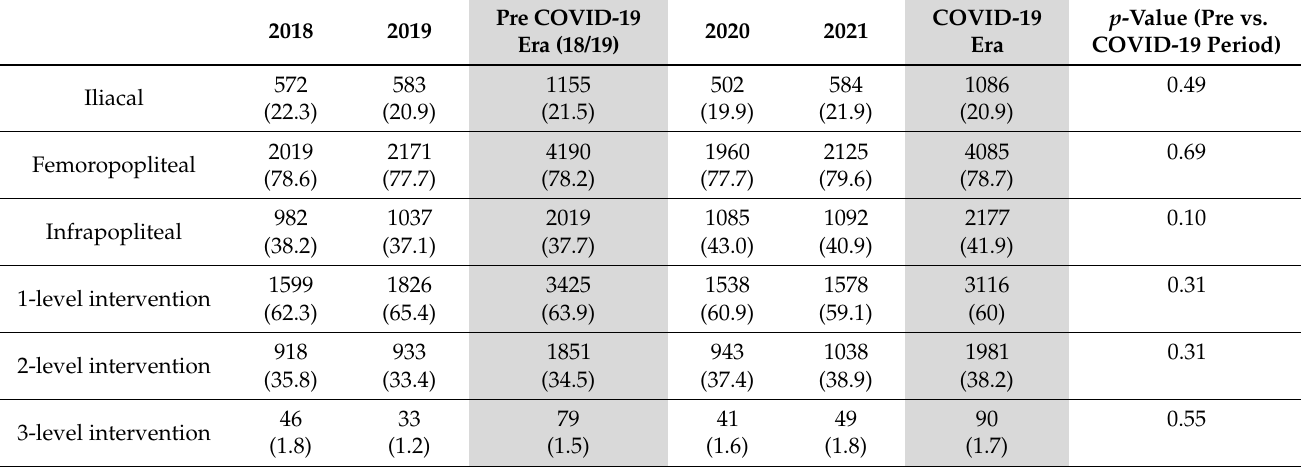
Table 3. Number of interventions according to level